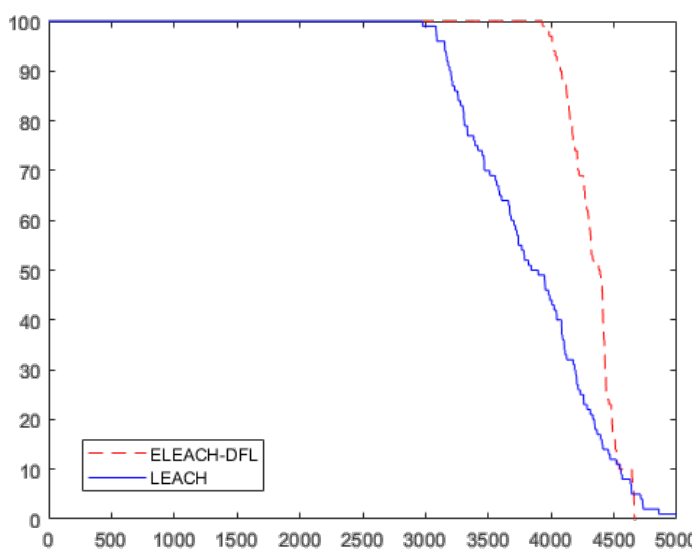
Figure 13. Network lifetime comparison between protocols (base station (BS)): inside the sensor field). Table 6. Network lifetime comparisons between protocols.